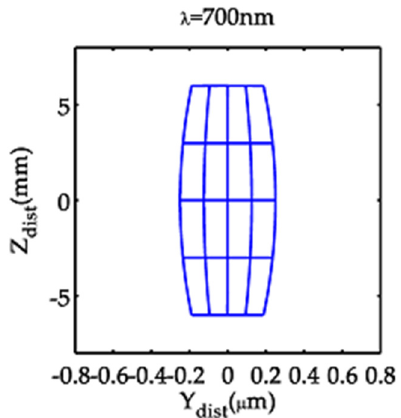
Figure 5. Distortion patterns of the model optical system for a mesh-like source of dimension 25 μ m (s) × 12 mm (z) with line separations of Δ s = 6.25 μ m and Δ z = 3 mm.